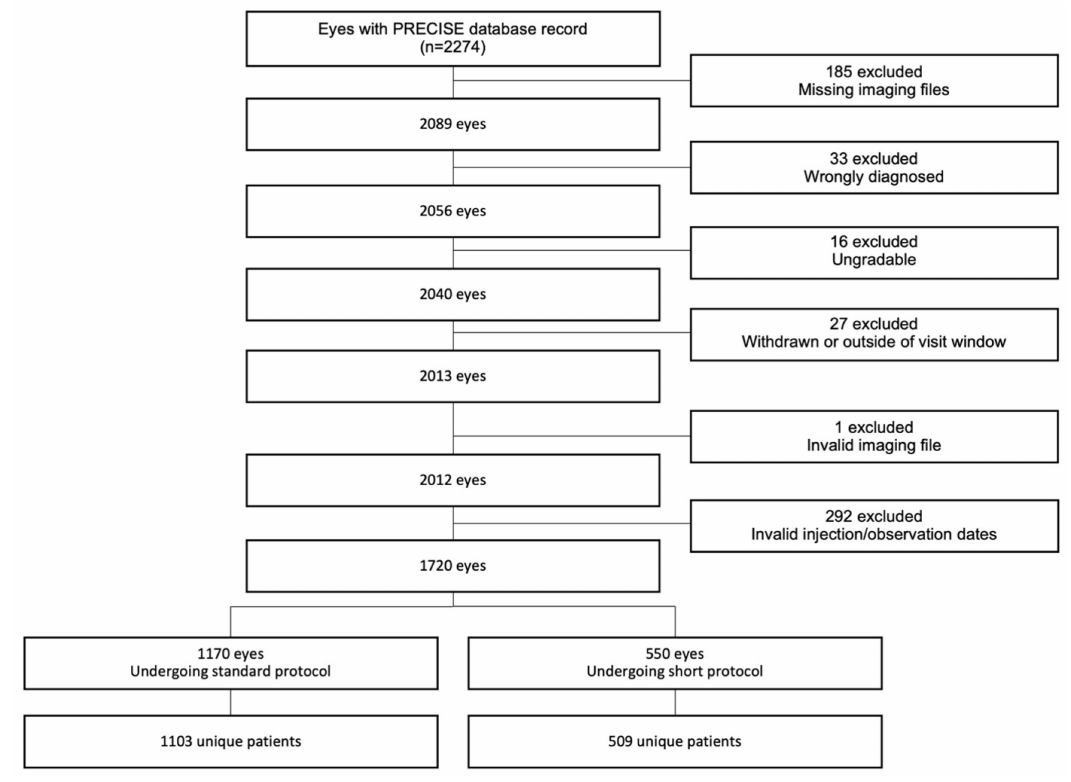
Figure 1. Participant flow.